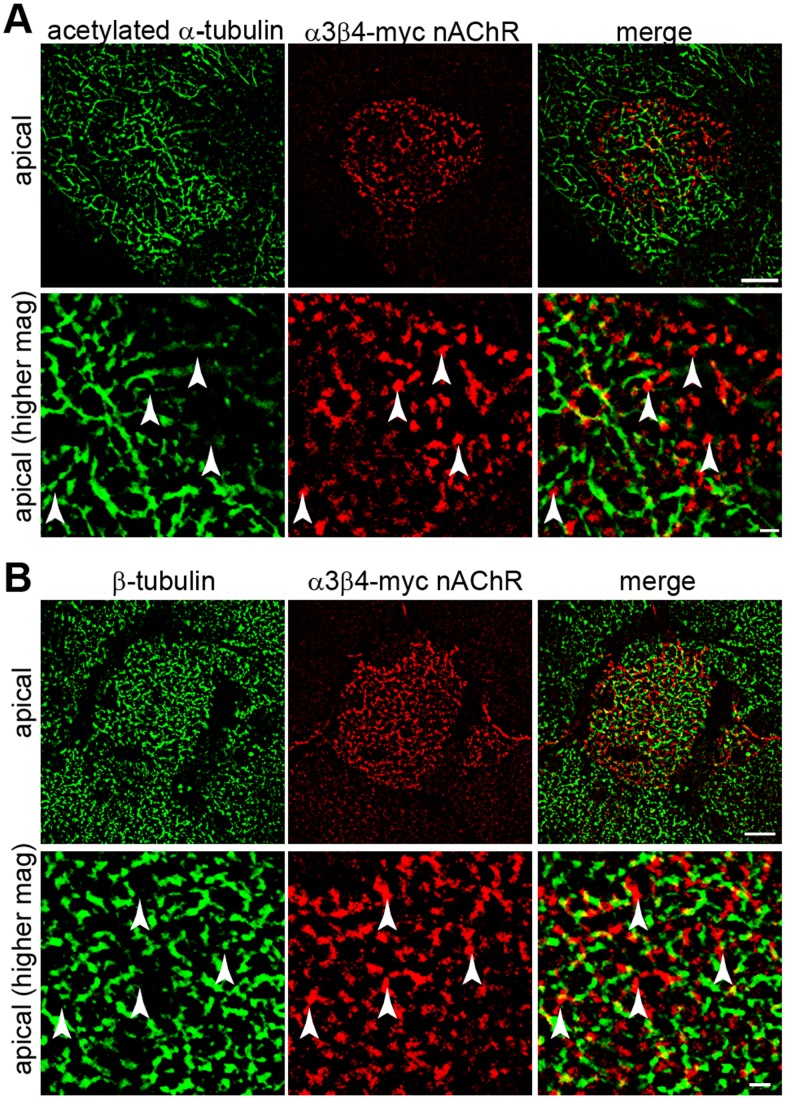
α3β4-myc nAChRs at to the apical cell surface do not colocalize with microtubules.Deconvoluted confocal images at low and high magnification of the apical surface of α3β4-myc nAChRs expressing Caco-2 cells immunolabeled with anti-acetylated α-tubulin (A) and β-tubulin (B) antibodies show no colocalization of α3β4-myc nAChRs with microtubules (arrowheads). Scale bar in lower magnification images (top row in A and B), 5 µm; scale bar in higher magnification images (lower row in A and B), 1 µm.